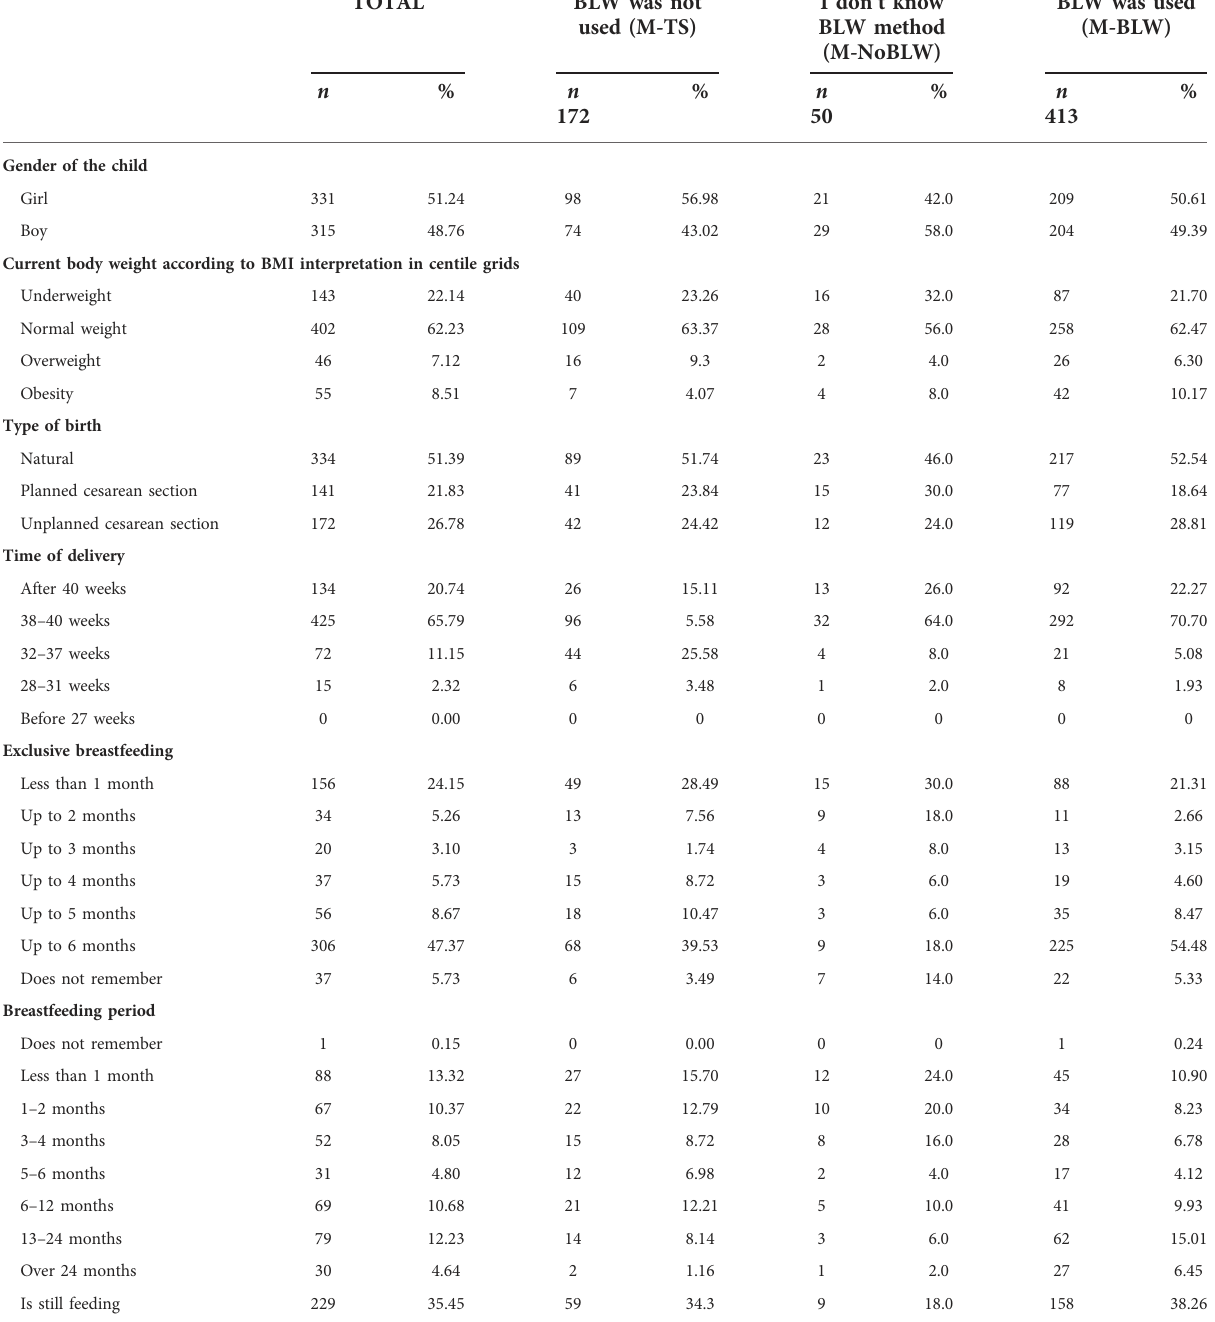
TABLE 3 Characteristics of the study group of children ( N =646).